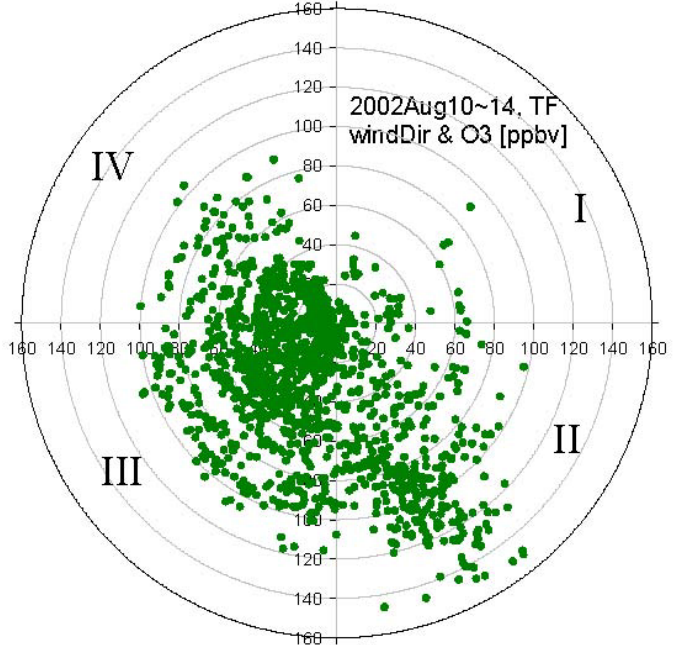
Figure 11. The observations of O and wind directions at TF from 10–14 August. Radial 3 scales present O mixing ratios from 0 to 160 ppbv, in 10 ppbv interval. Angular degrees in 3 clockwise present wind directions. In degrees of 0°–90° are northerly-to-easterly winds (I) ; 90°–180° are easterly-to-southerly winds (II) ; 180°–270° are southerly-to-westerly winds (III) ; and 270°–360° are westerly-to-northerly winds (IV).